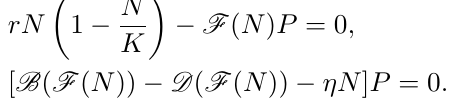
Fig. 1. Behavior of E ( N